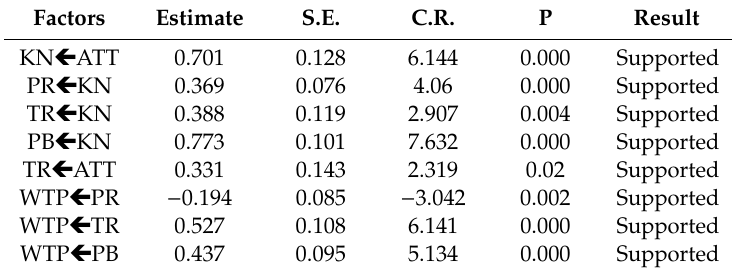
Table 4. Estimated regression weights of the structural model (First Survey)